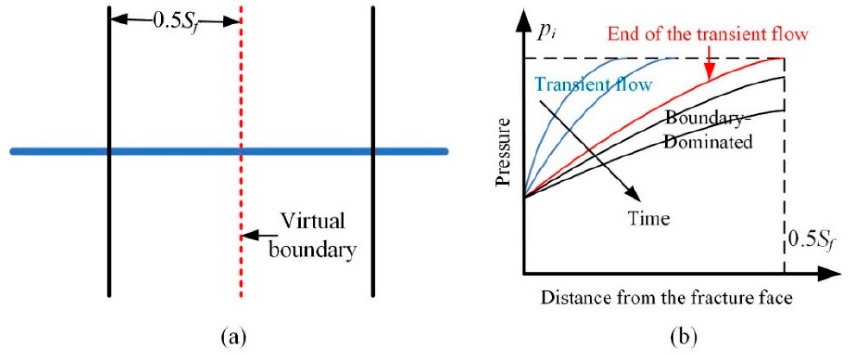
Figure 1. Schematic chart between two fractures. ( a ) Virtual boundary between two fractures. ( b ) Figure 1 . Schematic chart between two fractures. (a) Virtual boundary between two fractures. (b) Schematic chart of pressure Schematic chart of pressure distribution.